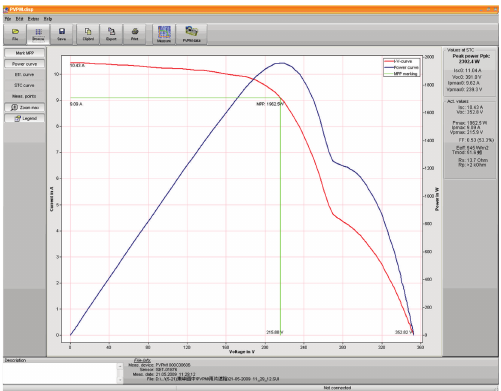
Figure 6: Measured P-V and I-V curves of a photovoltaic power module array when two modules were shaded, the irradiation was 945 W/m 2 , and the PV module surface temperature was at 51.6 ∘ C.